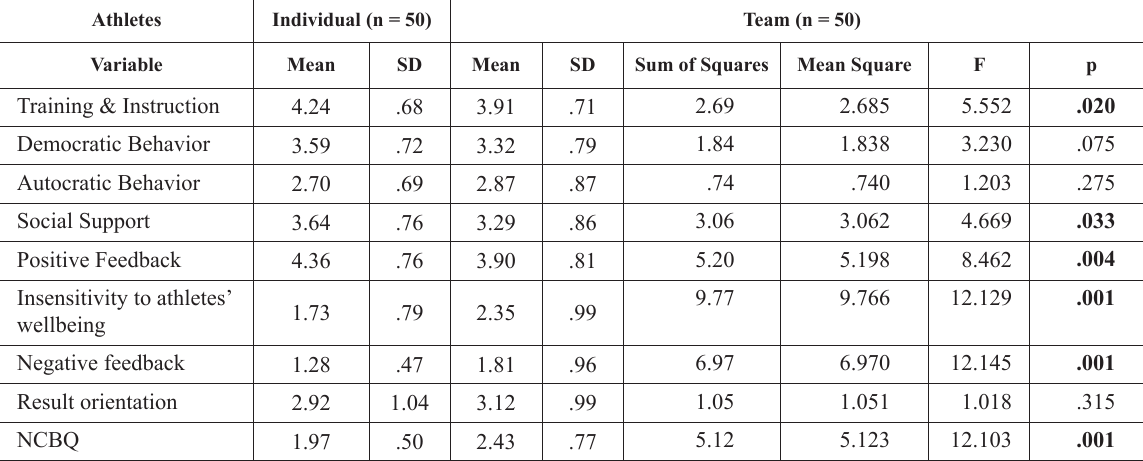
Table 2. Descriptive Statistics and ANOVA